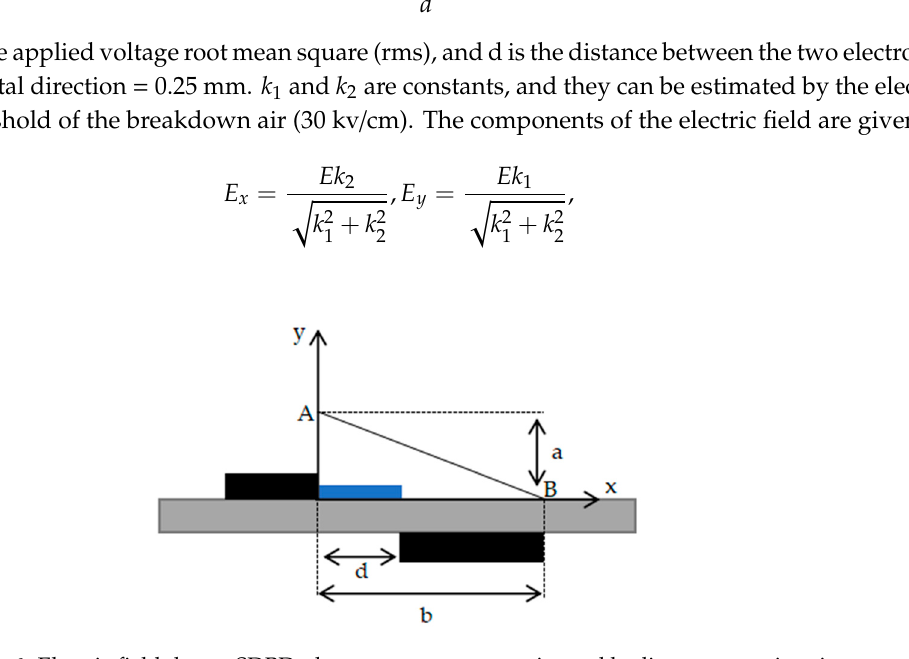
Figure 6. Electric field due to SDBD plasma actuator approximated by linear approximation.